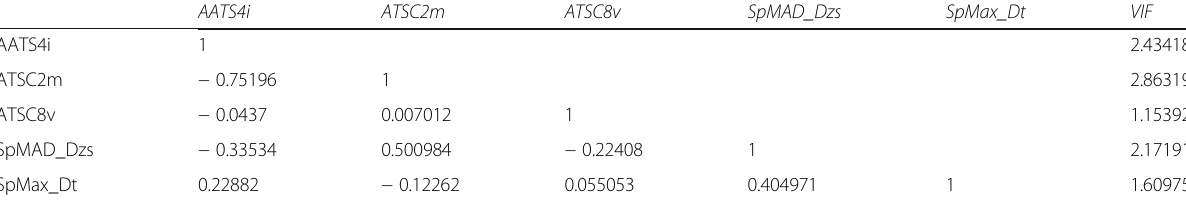
Table 5 The correlation analysis and VIF of descriptors in the model building set AATS4i ATSC2m